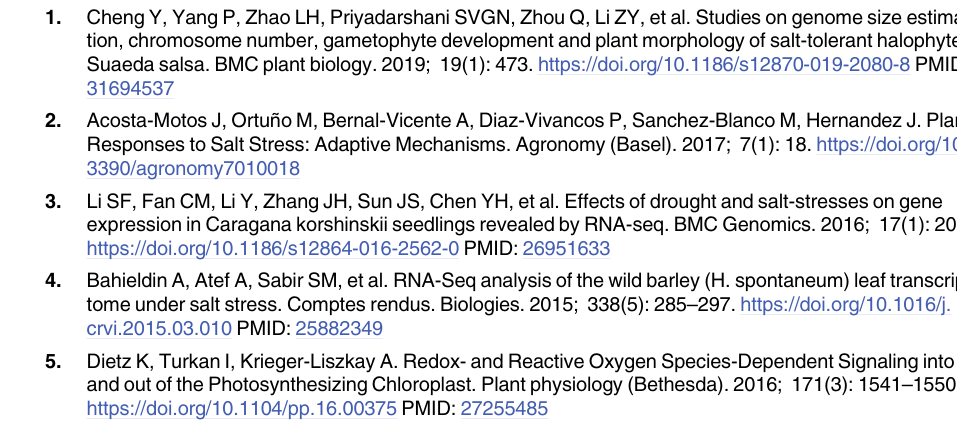
S1 Table. Sequences of specific primers. S2 Table. Randomly select 8 differentially expressed